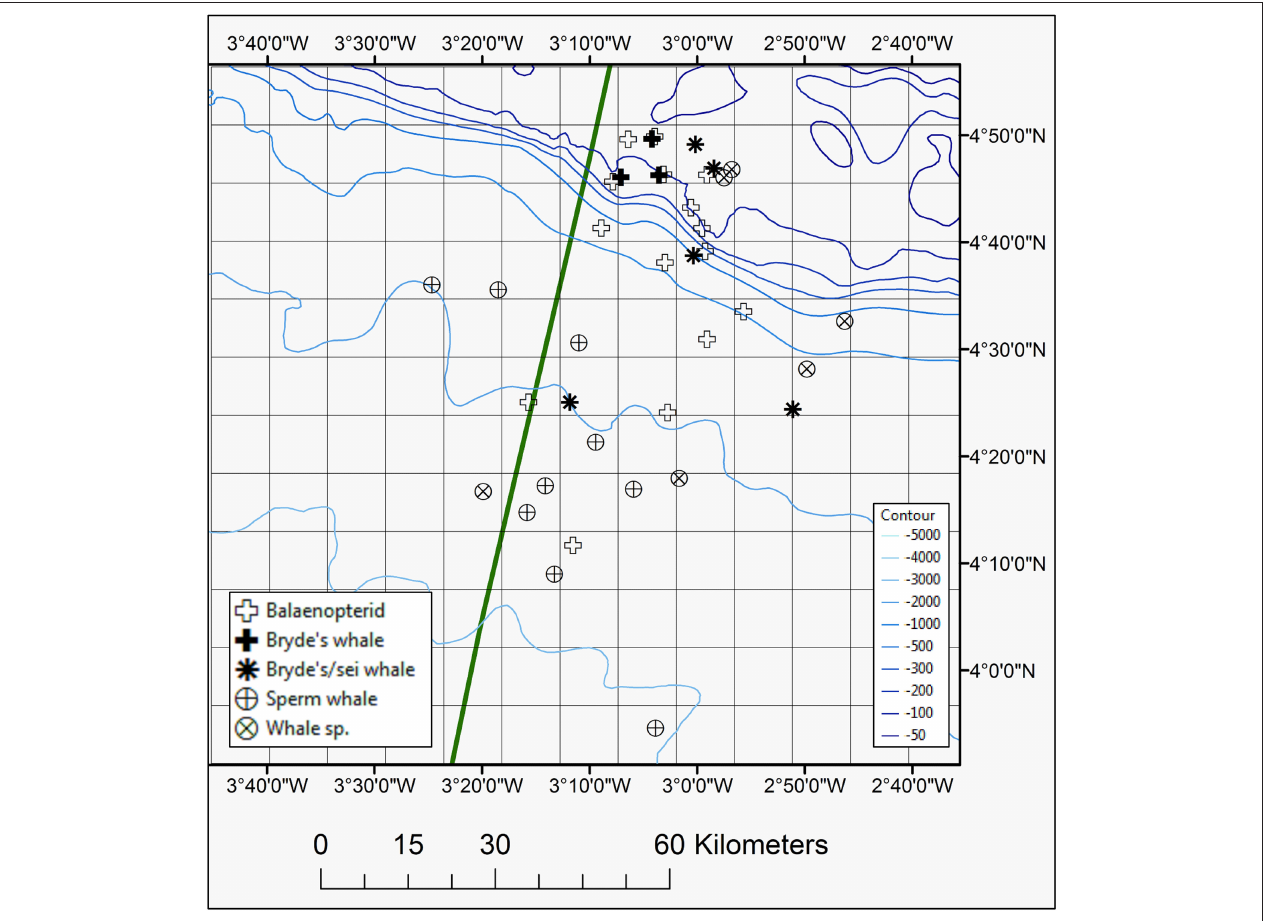
FIGURE 3 | Map showing positions of whales species seen during the 2013 and 2014 surveys, including Bryde’s whale, Bryde’s/sei whale, sperm whale, unidentified balaenopterid species, or unidentified whale species. The EEZ border between Côte d’Ivoire and Ghana is also shown (green thick